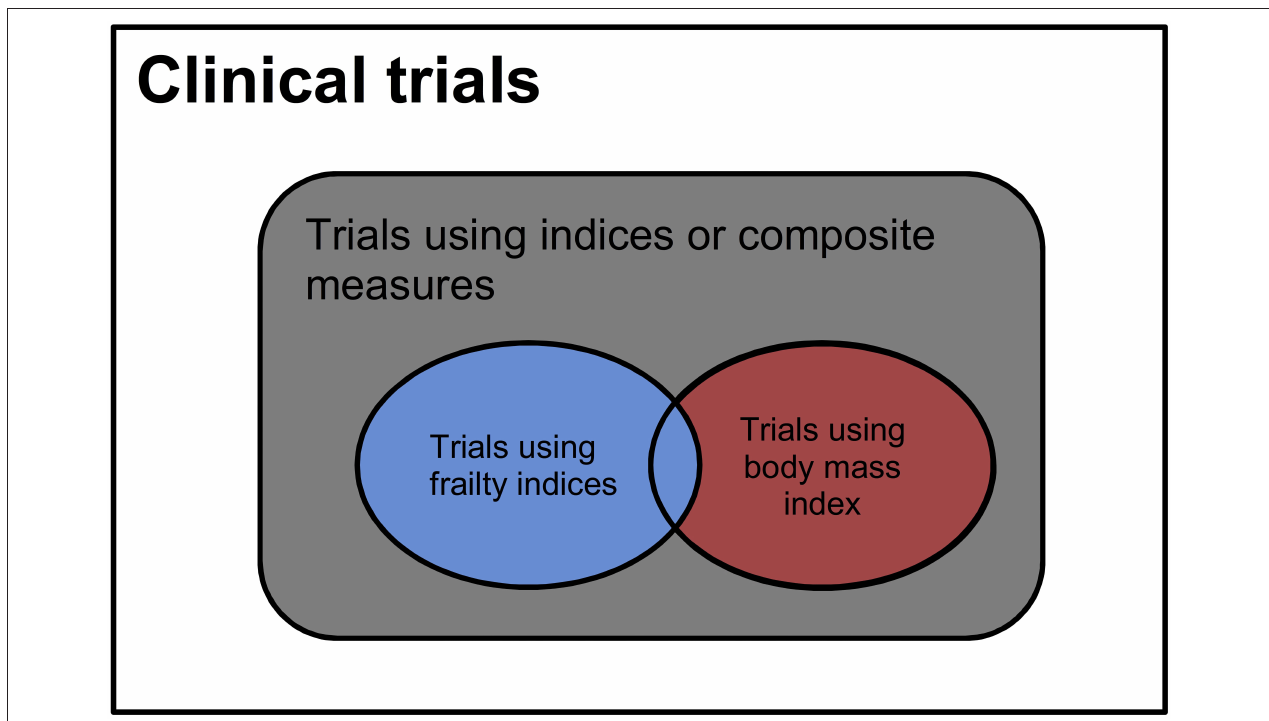
FIGURE 1 | Distribution of clinical trials of different interpretability. Blue = trials involving the diseases or measures of poor to fair interpretability, red = trials using body mass index that is highly interpretable, black = trials involving the diseases or measures of unknown interpretability.